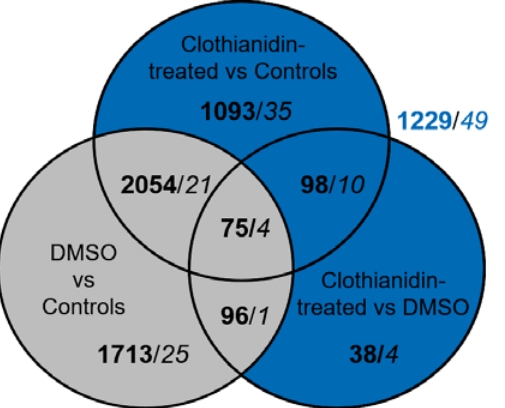
Figure 3. Differential expression analysis between the 3 experimental conditions for both transcriptomic and proteomic analysis. Venn diagram of transcriptomic and proteomic analyses of A. ipsilon brains in the 3 experimental conditions (controls, DMSO-treated, and clothianidin-treated). For transcriptomic results (values in bold), differentially expressed genes are indicated (FDR < 0.01). For proteomic results (values in italics), spots showing a significant difference in protein ratio values ≤− 1.25 or ≥ 1.25 (Student T -Test) are indicated. The grey area indicates proteins/transcripts for which a DMSO effect was observed, while the blue area indicates a clothianidin effect. Blue numbers outside of the Venn diagram are the total numbers of transcripts and proteins for which the expression is modified following clothianidin exposure without the DMSO effect.